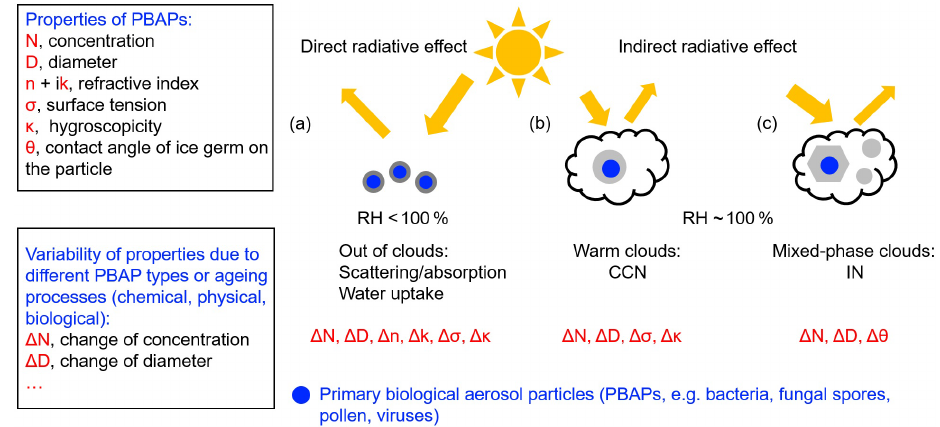
Figure 1. Schematic of the influence of PBAP properties and ageing processes on direct and indirect radiative effects. (a) The direct radiative forcing might be influenced by PBAP concentration ( N PBAP ), diameter ( D PBAP ), refractive index ( m PBAP = n + ik ), surface tension ( σ PBAP ), and hygroscopicity ( κ PBAP ) at RH < 100%. (b) N PBAP , D PBAP , σ PBAP , and κ PBAP might affect CCN activity and properties of warm